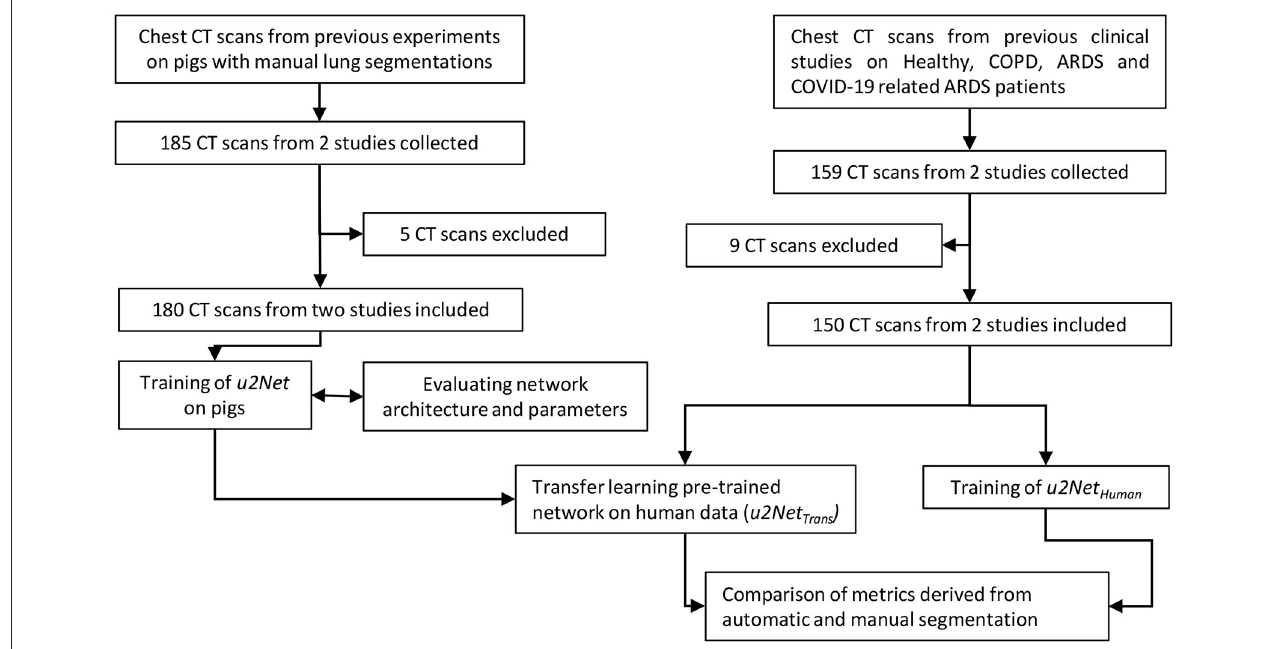
FIGURE 1 | Flow chart of the design process applied (CT scans were excluded if manual segmentations were of poor